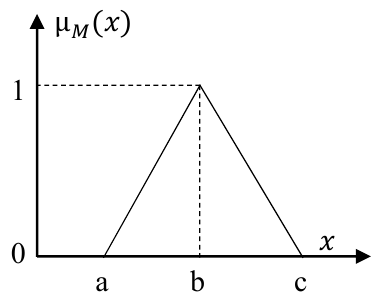
Figure 3. Triangular fuzzy set membership function.